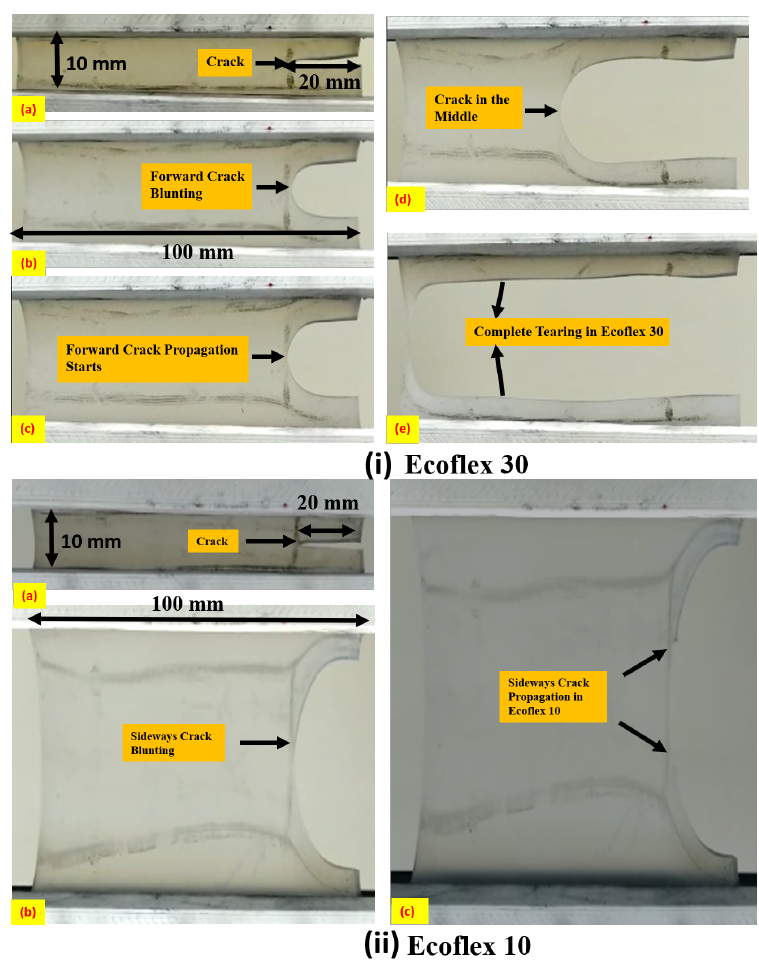
Figure 2. Representation of ( i ) forward crack propagation of Ecoflex 30 at a strain rate of 40 mm/min; ( a ) 20 mm notch length; ( b ) blunting of forward crack; ( c ) starting of forward crack propagation; ( d ) crack reaches at the middle of the specimen; ( e ) tearing of Ecoflex 30 in two parts. ( ii ) Sideways crack propagation of Ecoflex 10 of thickness 0.6 mm at a strain rate of 40 mm/min; ( a ) 20 mm initial notch; ( b ) blunting of sideways crack; ( c ) propagation of sideways